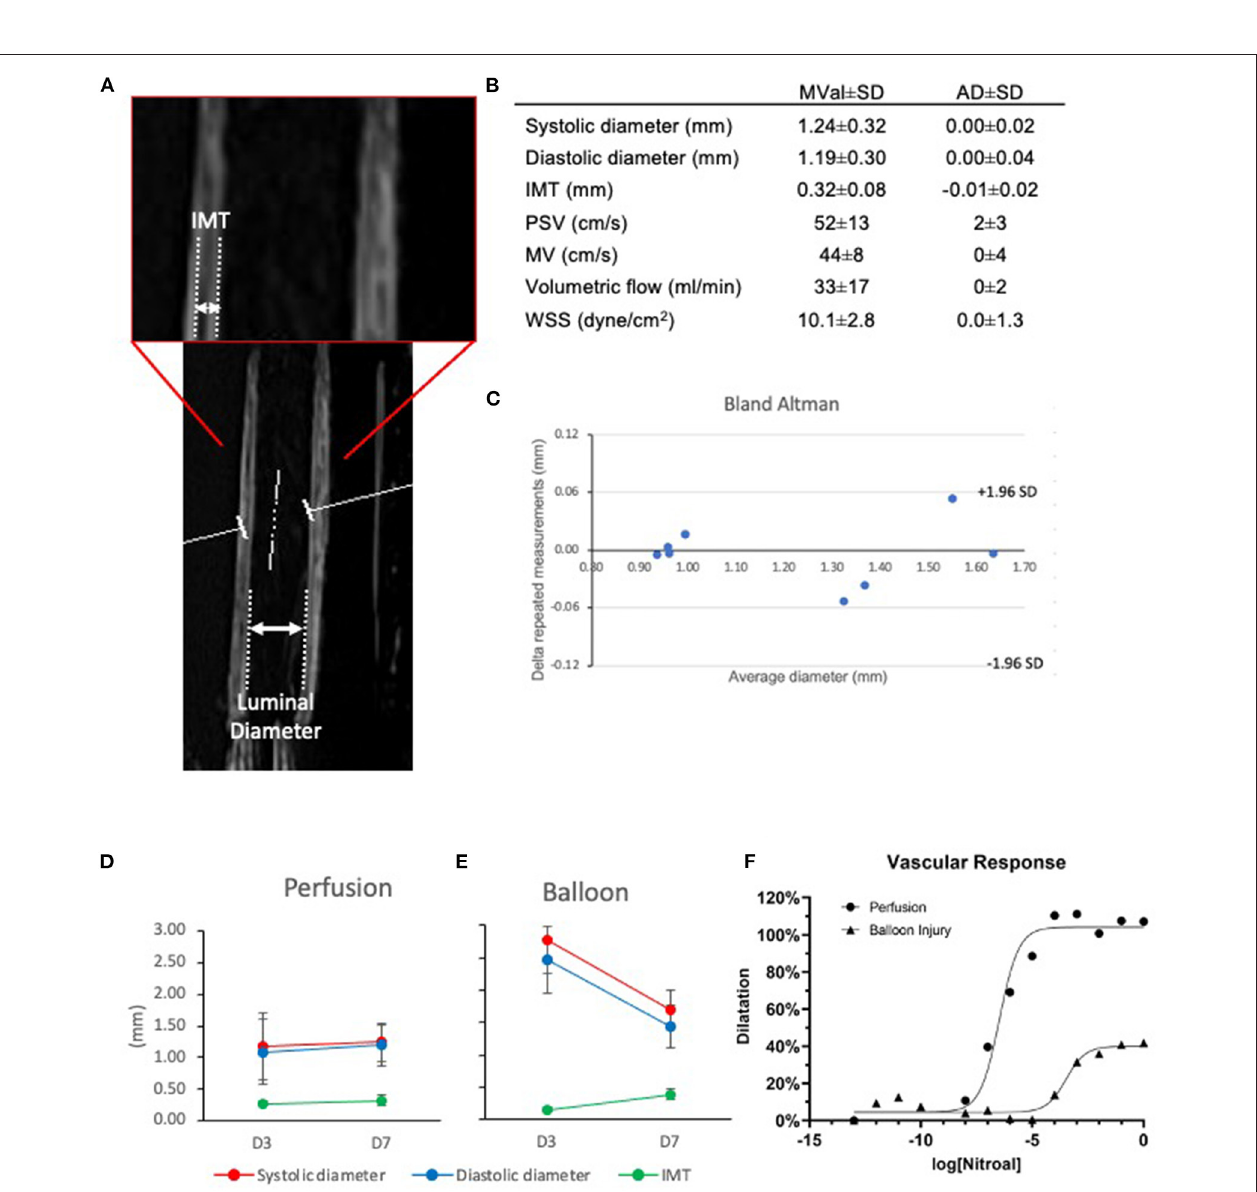
FIGURE 4 | Ultrasound evaluation of native and angioplastied carotid arteries after culture reveal in vivo relevant culture conditions and impairment after injury. Representative ultrasound image of an artery in culture (A) , highlighting the morphological parameters captured (B) . Mean value (MVal) and average deviation (AD) of vessel parameters in flow culture at day 7. IMT, intima media thickness; PSV, peak systolic velocity; MV, mean velocity; WSS, wall shear stress; Systolic, maximal pulsatile diameter; Diastolic, minimal pulsatile diameter ( n = 4). Bland Altman plot shows the consistency of repeated measures within the samples (C) . Healthy Perfusion (D) and angioplastied Balloon (E) arteries were cultured for 3 and 7 days in EasyFlow and their systolic and diastolic diameter, the intima-media thickness (IMT), and their dose-response to endothelial-independent vasodilator nitroglycerin (F) were quantified by Doppler ultrasound, n = 2–4.